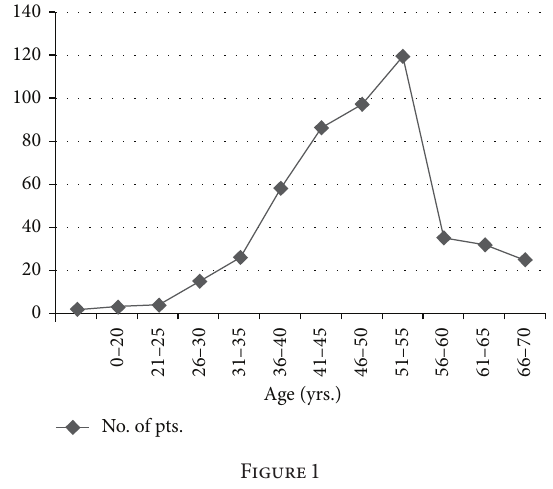
of smoking whereas 62% from old age group had the same history ( 𝑃 value 0.014 sig). Main comparative symptomatol- ogy between the 2 groups was weight loss 64% in < 40 yrs and 80% in > 40 yrs age groups, anorexia 52% versus 79% (0.000; sig), malena 16% versus 6%, constipation 4% versus 32%, and dysphagia 2% versus 22%; all these findings were statistically significant, whereas rest of the symptoms on comparison were statistically insignificant. Amongst the signs, gastric splash (succussion splash) 145 versus 35% had a statistically significant 𝑃 value (0.003), whereas rest of the signs were not significant statistically. The most common type of lesion in young patients was infiltrative type (38%) while it was polypoid (58%) in older patients and this difference again was statistically significant as the distribution of lesion in various parts of stomach was statistically significant. 71% of young patients had poorly differentiated lesions and 40% older patients had moderately differentiated lesions. 69% young and 33% old patients had diffuse type of lesions, whereas 25% young and 58% old patients had intestinal type of lesions. Resection was possible in 50% young versus 69% old patients. 26% young versus 10% old patients underwent only palliative gastrojejunostomy. The most common operation was lower partial gastrectomy in 68% versus 49%. Amongst the intraoperative findings peritoneal metastasis was seen in 17.4% in young patients versus 6.5% in old patients. The rest of all findings on comparison were statistically insignificant. 50% young versus 35% old patients presented in stage IV as per AJCC classification ( 𝑃 value 0.004; Sig). None of the patients presented as stage 1 disease in young group. Chemoradiotherapy for young versus old patients was 66.5% versus 51%; only chemotherapy was 27.5 versus 42%; and only radiotherapy was 6% versus 7% given as adjuvant therapy. Most common complication of surgery was wound infection 9% versus 14% followed by ileus 10% versus 11%. The survival of young patients is shown in Table 1. Mean survival was 10.3 months. Out of 33 young patients in prospective study, 16 died during the study period. Genetic alterations of p53 gene in gastric cancer are shown in Tables 2(a), 2(b), and